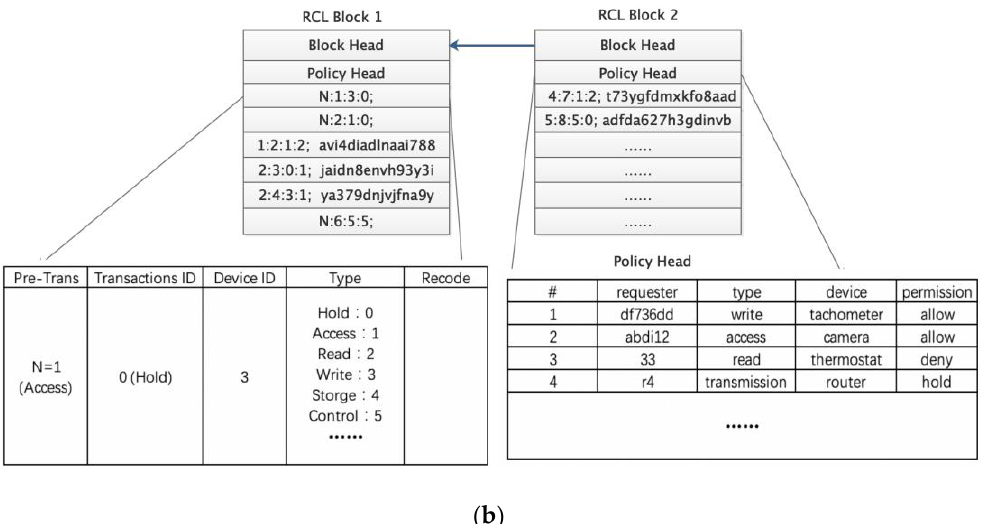
Figure 3. A Layered Lightweight Blockchain Framework (LLBF): ( a ) Layered Blockchain network model; ( b ) Structural design of resource constrained layer (RCL) block.